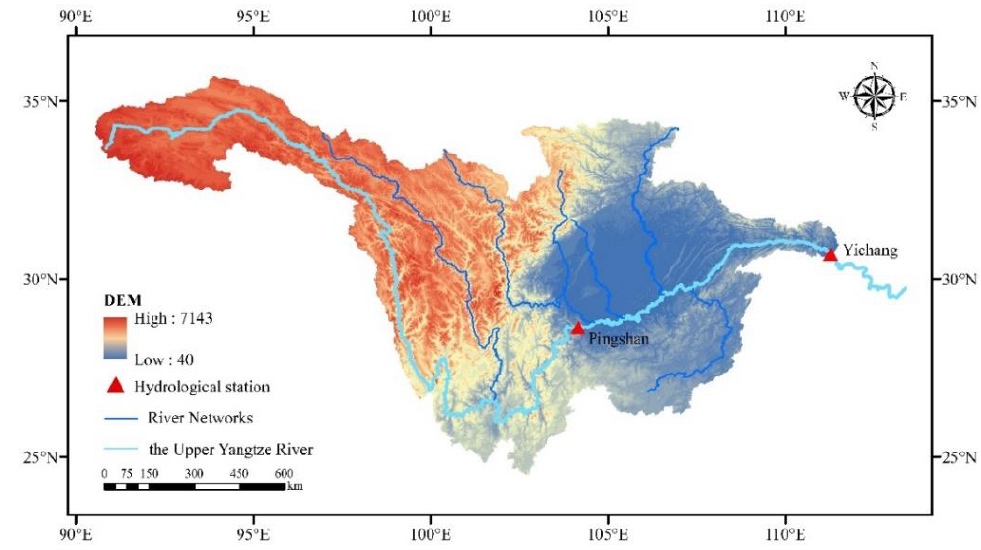
Figure 4. Study area and location of the two hydrological stations in Upper Yangtze River Basin. The monthly runoff data analyzed in this paper are from the Pingshan and Yichang hydrological station in UYR Basin, two key control stations in Upper Yangtze River. Their position is shown in Figure 4. The monthly runoff data covers the period from January 1940 to December 2010 for Pingshan, and January 1884 to December 2020 for Yichang, respectively. 80% of the monthly runoff data were used for training, 20% were used for testing. In the training dataset, approximately 90% of the data were utilized for model parameter optimization and the remainder were utilized for validation. In this work, all of the data preprocessing and management was performed by Numpy and Pandas scientific computing package in